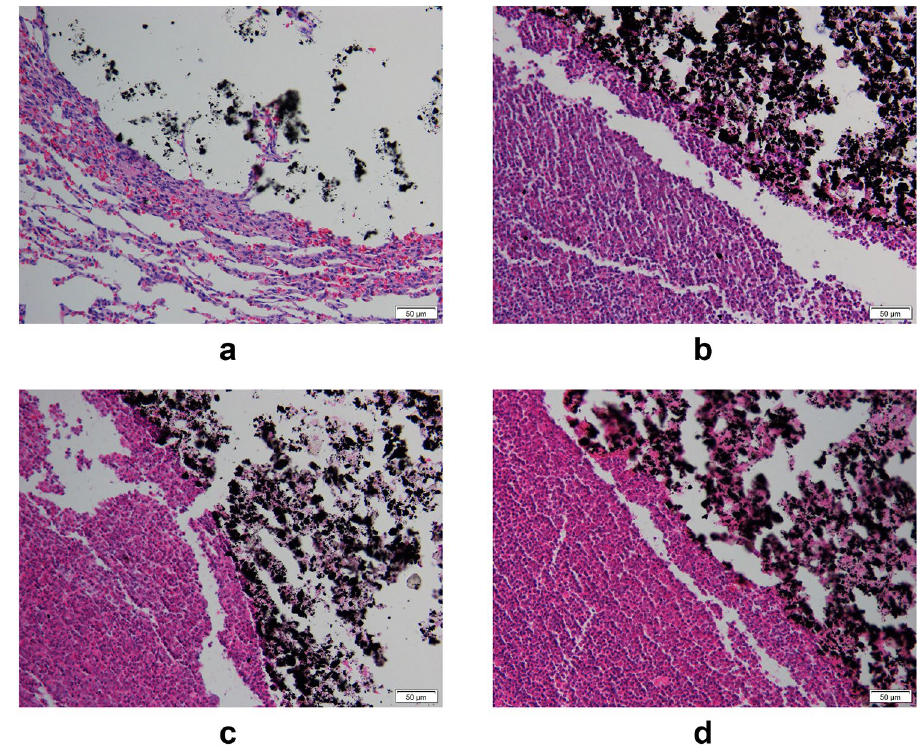
Figure 11. ( a – d ) The injection site on postoperative days 1, 3, 5, and 7, respectively (hematoxylin–eosin staining, 200×).